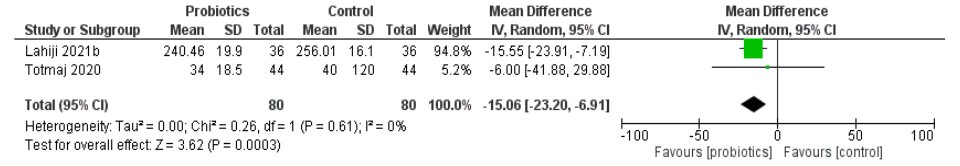
Figure 7. Meta-analysis for tumor necrosis factor-alpha (TNF- α ).